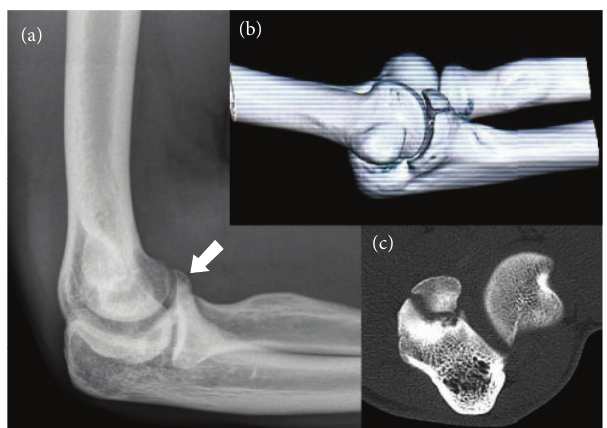
Figure 1: Imaging of the elbow at diagnosis. (a) X-ray: irregularity of the anterior elbow joint. (b) Three-dimensional CT-scan reconstruction of ancient coronoid process fracture. (c) Axial view of elbow on